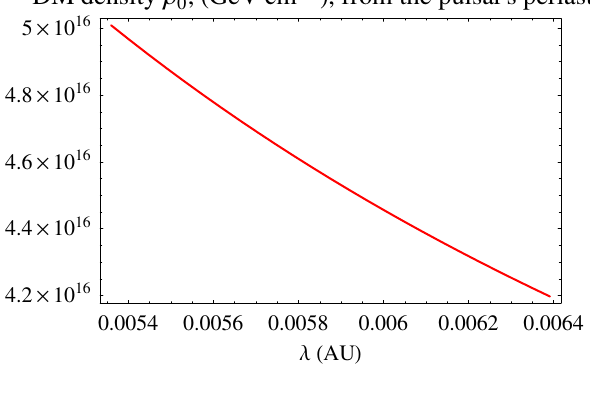
Figure 3. Upper bounds, in GeV cm − 3 (1 GeV cm − 3 is equivalent to 1 . 78 on the DM density parameter ρ 0 in the PSR J0737-3039A/B system as a function of λ (top panel) of Equation (5), and of λ and γ of Equation (11) (bottom panel). The characteristic length λ , in AU, is assumed to vary from r min = a (1 periastron rate uncertainty of 0 . 03 ◦ year − 1 [62] was assumed for PSR J0737-3039A. It was compared with the theoretical predictions of Equation (8) (top panel) and of Equation (13) (bottom